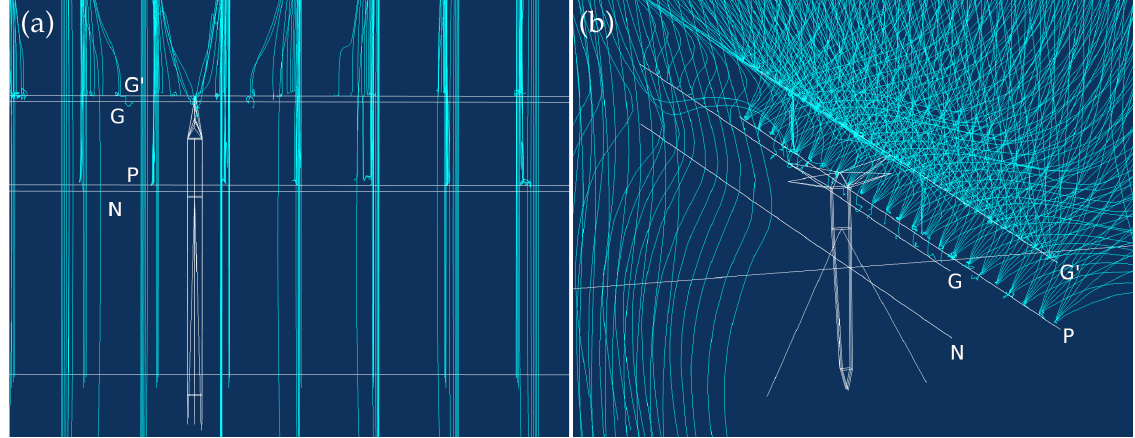
Figure 9. Lightning incidence (cyan lines) for λ = 50 m: ( a ) Perspective view and ( b ) side